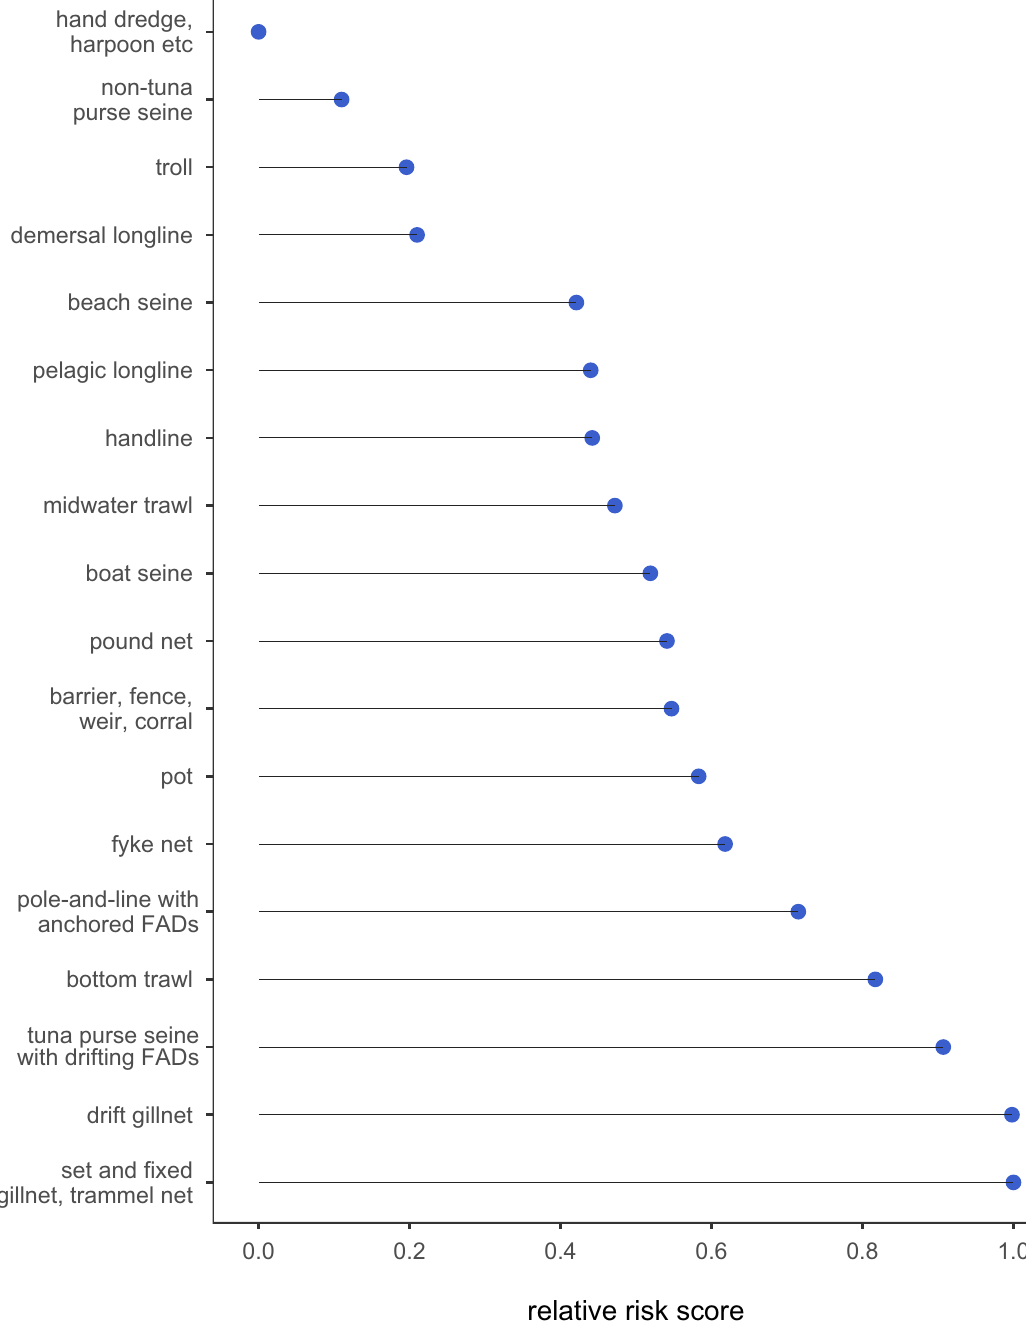
Figure 1. Gear-specific relative risk from abandoned, lost and discarded fishing gear (ALDFG). From the top of the y -axis, fishing gears are listed from lowest overall relative risk score, which accounts for: ( a ) rate of production of ALDFG, ( b ) fishing effort (accounts for gear-specific weight of total catch and geospatial area of fishing grounds), and ( c ) adverse ecological and socioeconomic impacts of ALDFG (accounts for: ghost fishing, dispersal and transfer of toxins and microplastic into marine food webs, dispersal of invasive alien species and microalgae that cause harmful algal blooms, habitat degradation, obstruction and safety risks to navigation and in-use fishing gear, and reduced socioeconomic, aesthetic and use values of coastal and nearshore habitats). The higher the relative risk score, the larger the amount of global adverse effects from ALDFG the gear is estimated to be causing, based on the quantity of derelict gear that gear leaks into the oceans and the relative adverse effects caused by ALDFG from that gear type. The first gear category includes boat and shore-based hand dredge, harpoon, spear, lance, tongs, rakes, and hand-collected, including